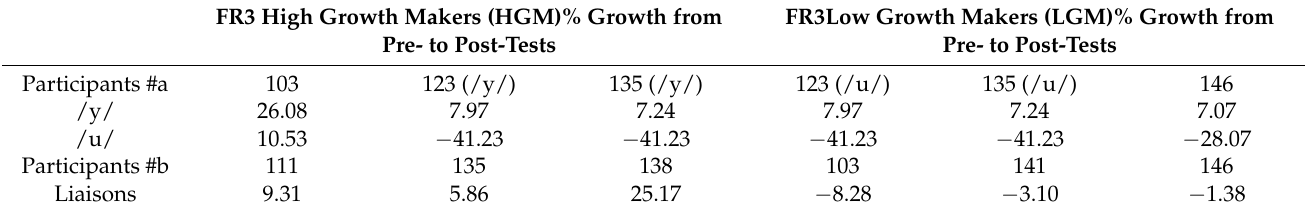
Table 8. Participants’ pronunciation growth from pre–post-tests in